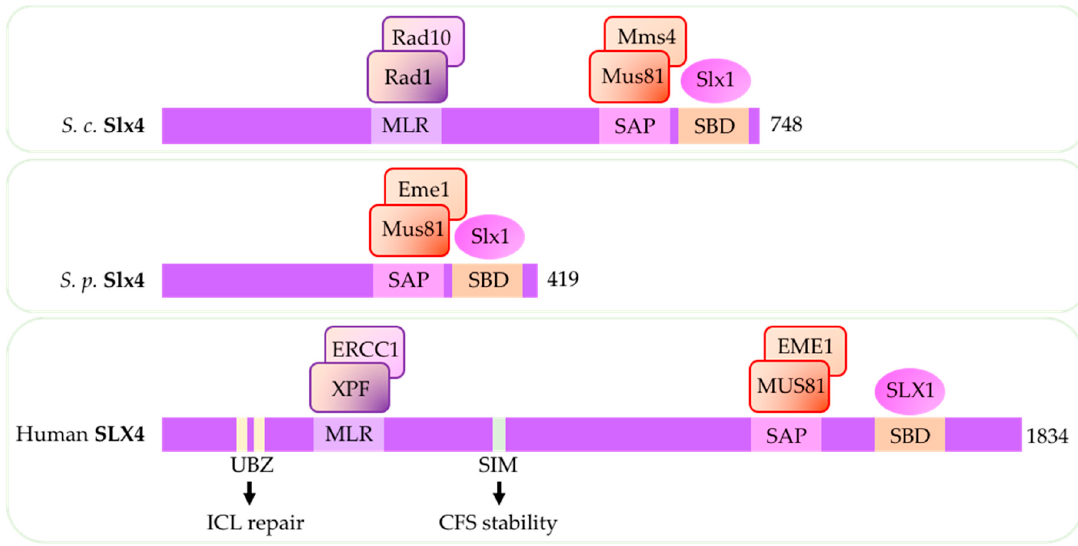
Figure 4. Important domains in SLX4. Across all three species ( S.p. , S.c. , and human), scaffold protein